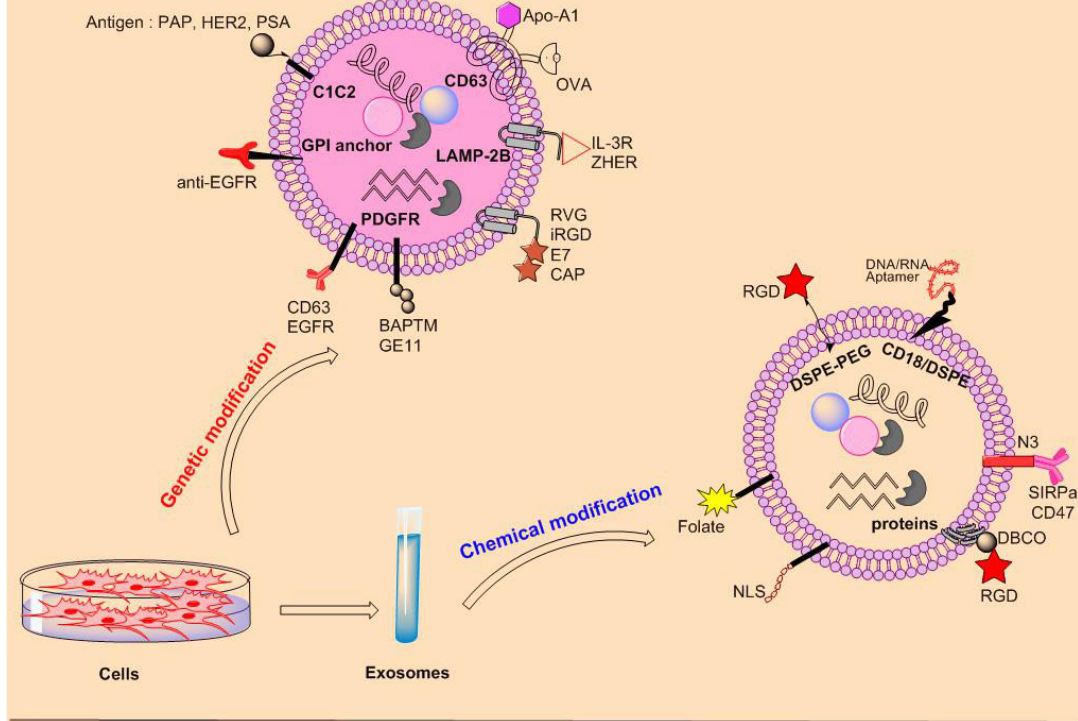
Figure 4. Schematic figure of the functionalization of exosomes surface. Exosomal surfaces can be functionalized by genetic modification and chemical modification. These approaches improve tumor targeting ability of exosomes.